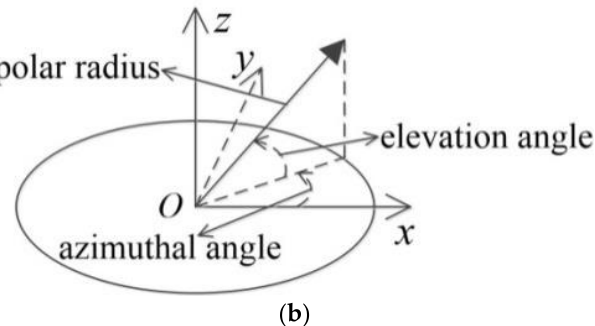
Figure 3. ( a ): Diagram of 22-channel system setup; ( b ): 3D coordinate system. Table 1. The location of related points for experiment 1.